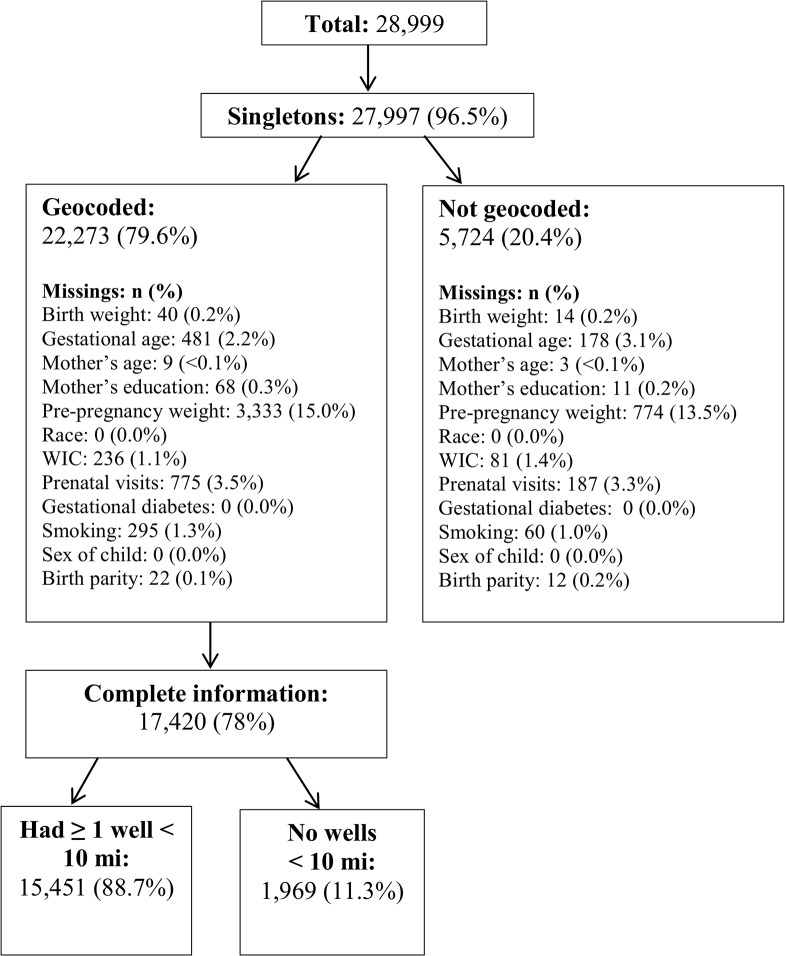
Flowchart of sample sizes and missing data for births in Butler, Washington, and Westmoreland Counties 2007–2010.